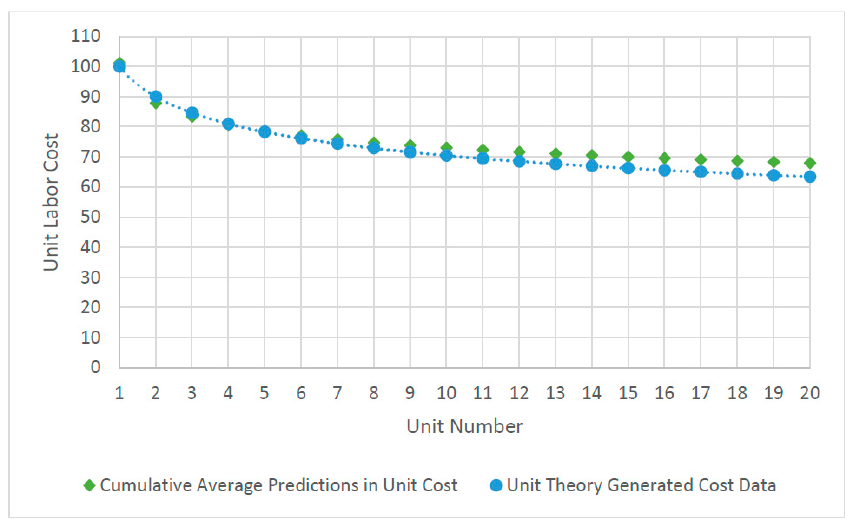
Figure 1. Wright’s Cumulative Average Theory vs. Crawford’s Unit Theory.